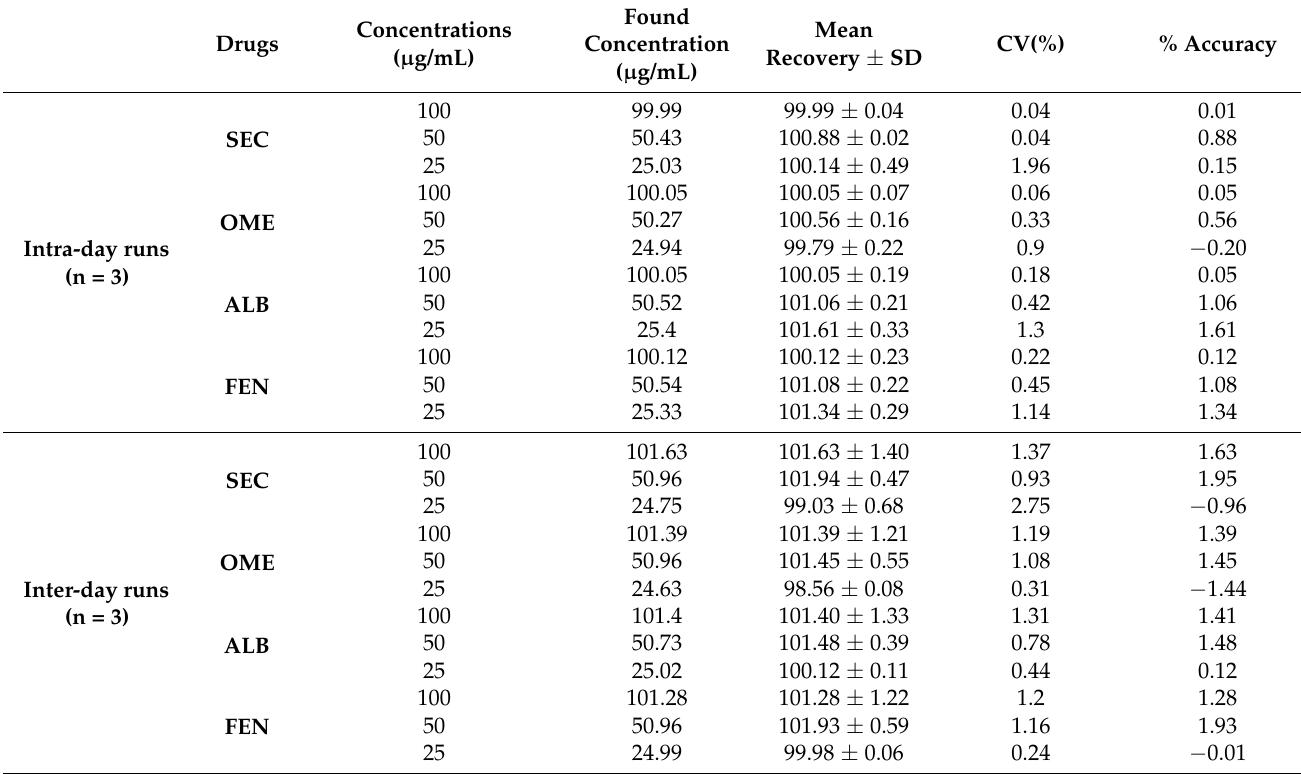
Table 5. Intra- and inter-day precision results of SEC, OME, ALB, and FEN in pure samples using the proposed method.